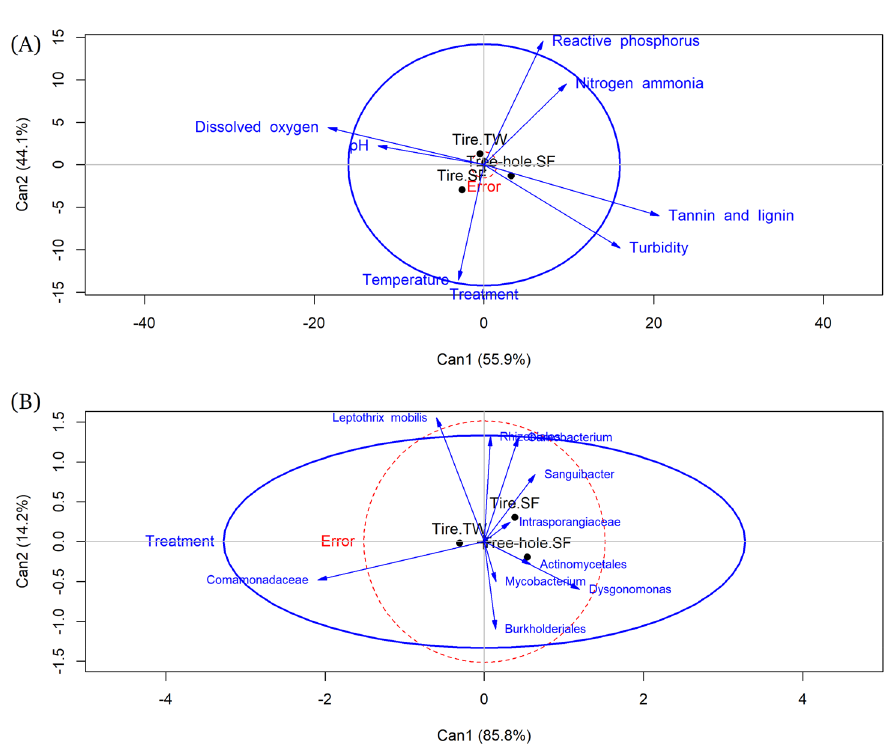
Figure 5. Canonical discriminant analysis of the correlation between water chemistry parameters and larval environment type ( A ); and the correlation between dominant bacterial OTUs in the water samples and larval environment type ( B ). The lines represent the h-plot of important water chemistry parameters, or dominant OTUs, the points represent the means for the larval environment type. The length of the line of the variable in the plot is proportional to its importance in separating the data into the three habitat